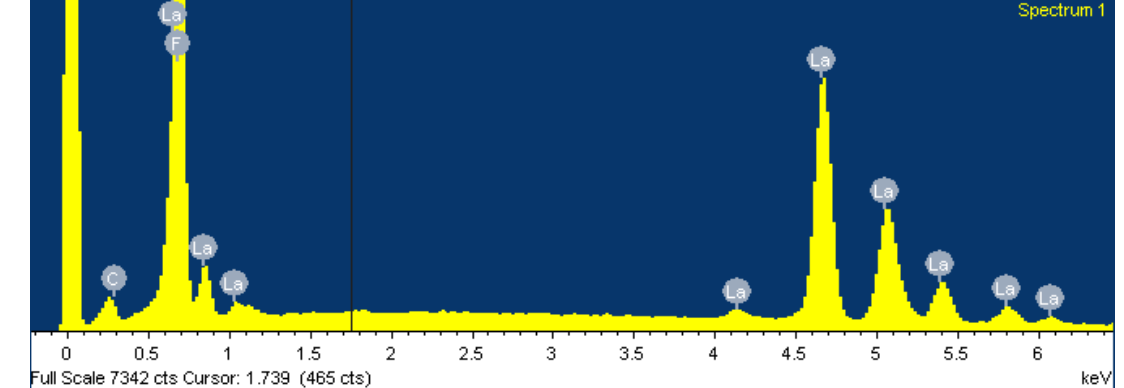
Figure 9. Spectrum of LaF 3 single-crystal membrane (with diameter of 8.0 mm and thickness of 1.0 mm, doped with 1.0% Eu) before Fe x O y NP loading.